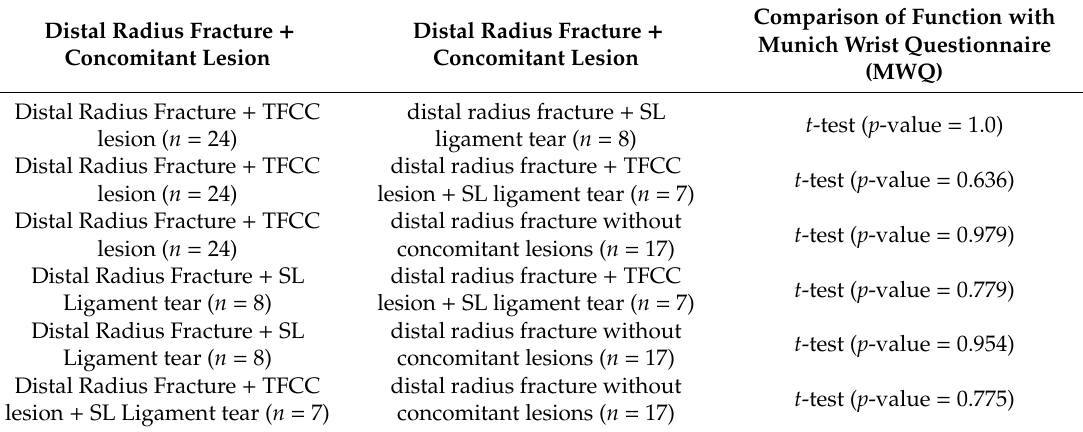
Table 2. Evaluation of the function using the MWQ.